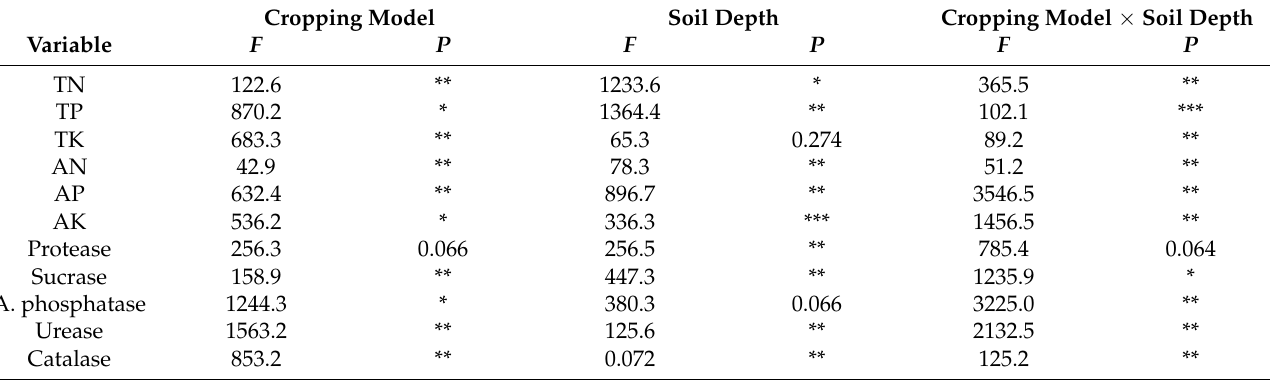
Table 3. Two-way ANOVA results for soil variables. *, ** and *** indicate a significant level at p < 0.05, p < 0.01 and p < 0.001,